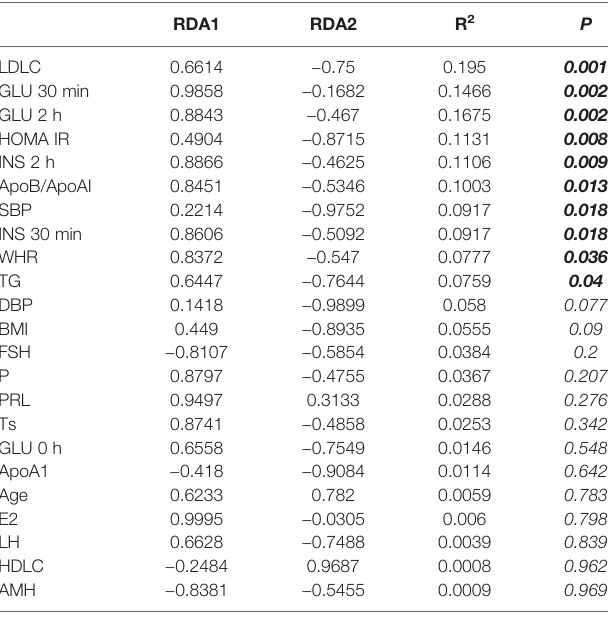
TABLE 1 | Relationship between sample distribution and clinical indicators (Redundancy